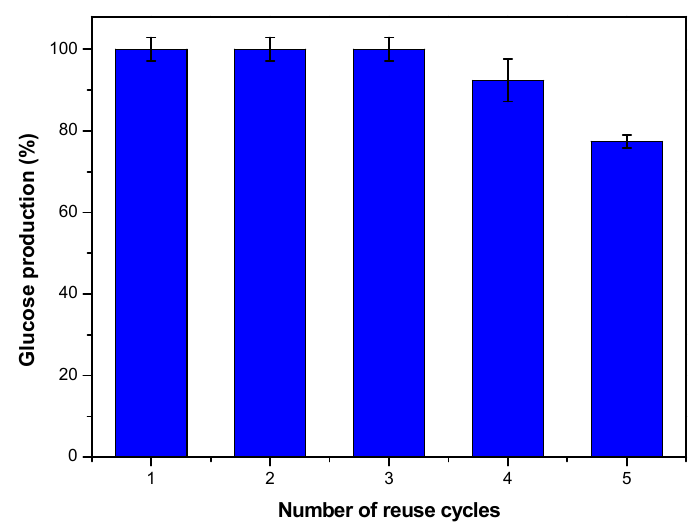
Figure 11. Histograms showing the glucose production (%) over the number of reuse cycles of cellulase / WSN-biocatalyst (data are reported with error bars).